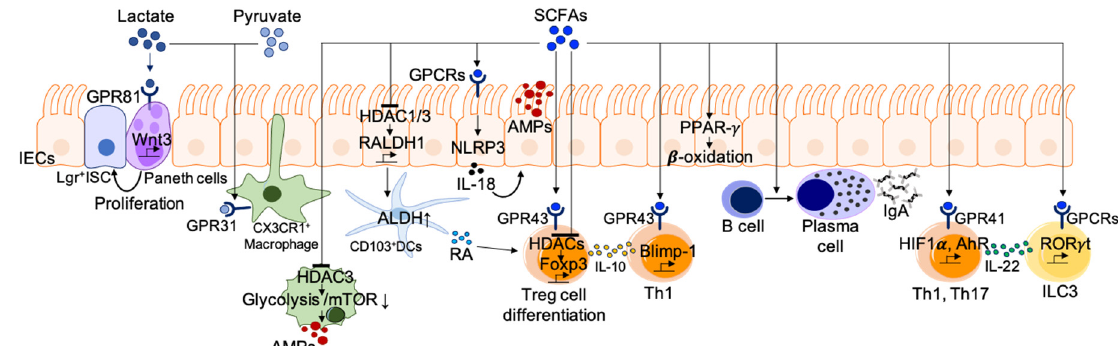
Figure 2. Immune regulation by carbohydrate metabolites. Lactate and pyruvate induce dendrite protrusion of intestinal CX3CR1 + macrophages via GRP31 to enhance the immune response. Lactate also maintains gut homeostasis via Wnt/ β -catenin signaling activation to induce intestinal stem cell proliferation. SCFAs act as HDAC inhibitors or stimulators for GPCRs to regulate intestinal immune homeostasis. SCFAs induce Treg cell differentiation, plasma B cell differentiation, and IL-22 production from ILC3 as well as Th1 and Th17 cells. Additionally, SCFAs regulate the activity of certain macrophages and dendritic cells (DCs). AhR, aryl hydrocarbon receptor; ALDH, aldehyde dehydrogenase; AMPs, anti-microbial peptides; GPCRs, G protein coupled receptor; HDAC, histone deacetylase; HIF1 α , hypoxia-inducible factor 1-alpha; ISC, intestinal stem cell; PPAR- γ , peroxisome proliferator-activated receptor- γ ; RA, retinoic acid.